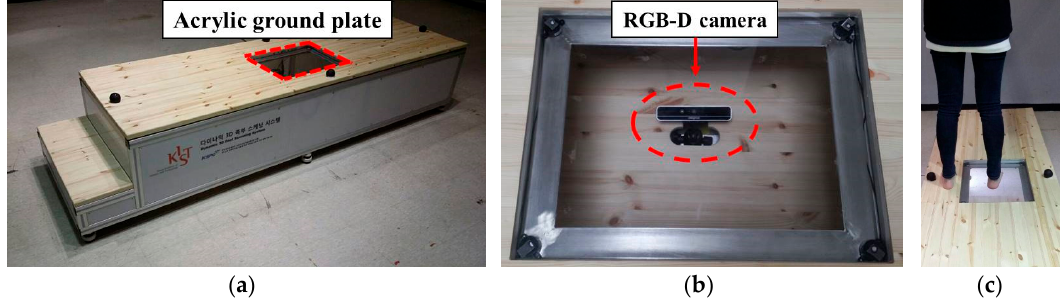
Figure 3. System installation: ( a ) scanning stage of the proposed system, ( b ) RGB-D camera beneath the transparent acrylic board, ( c ) sole of foot measurement using our system.